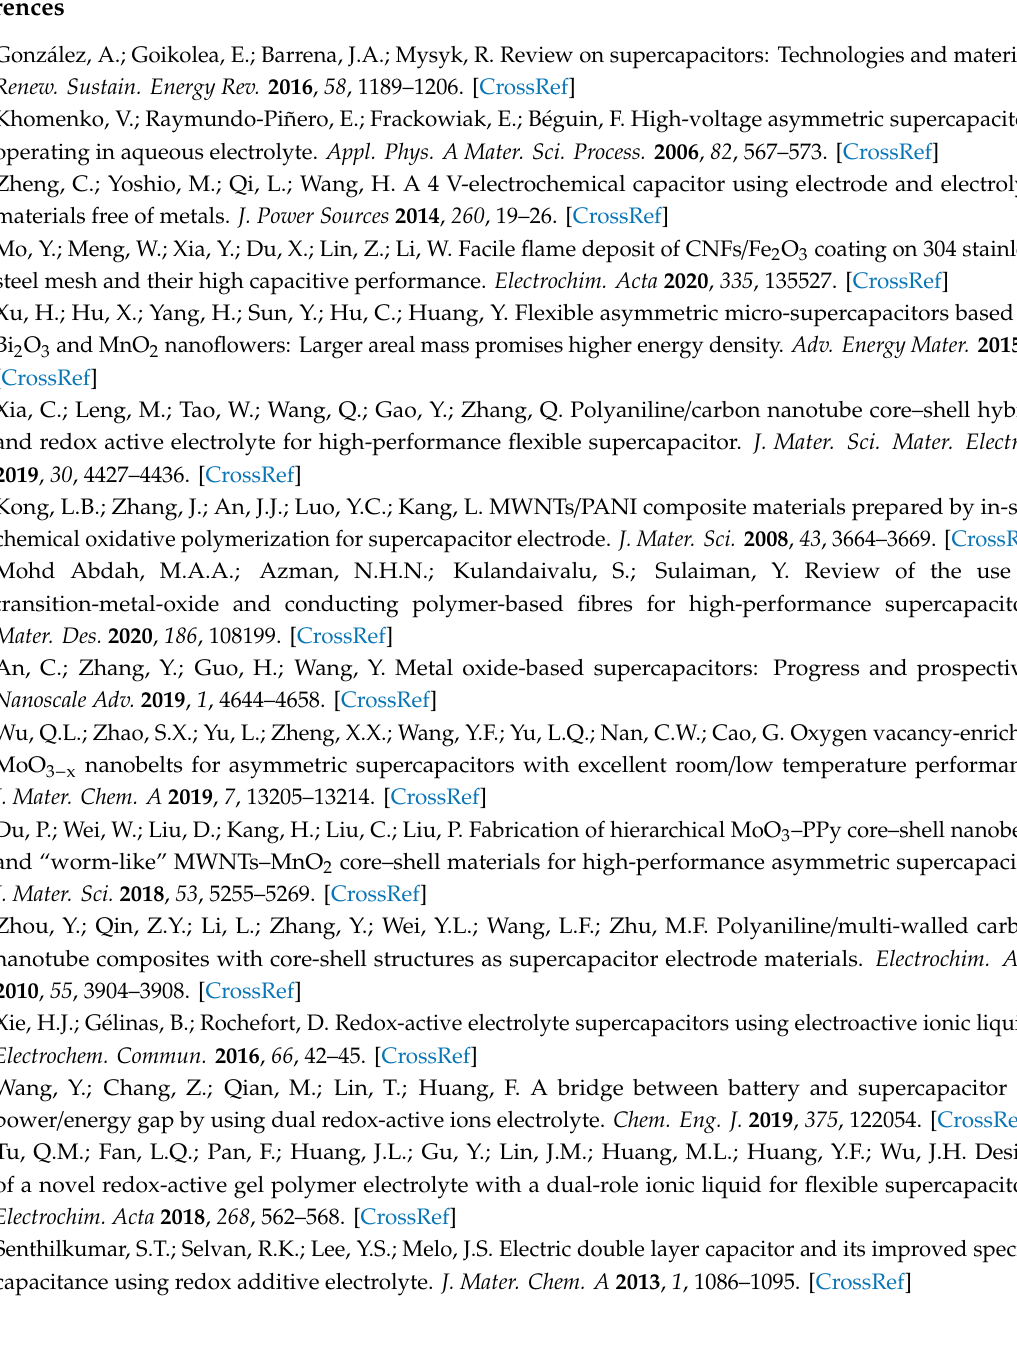
Table S1: Specific capacitance of PANI // MoO 3 ASCs and PANI / Ti single electrode in 0.1 M Fe 2 +/ 3 + / 0.5 M H 2 SO 4 calculated from GCD tests (Cm) and CV curves